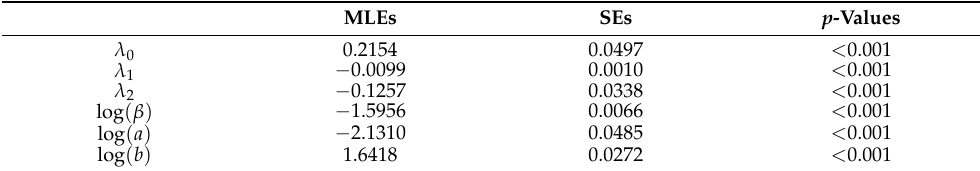
Table 8. Estimation results from the WBP regression model for COVID-19 data in Campinas. MLEs SEs